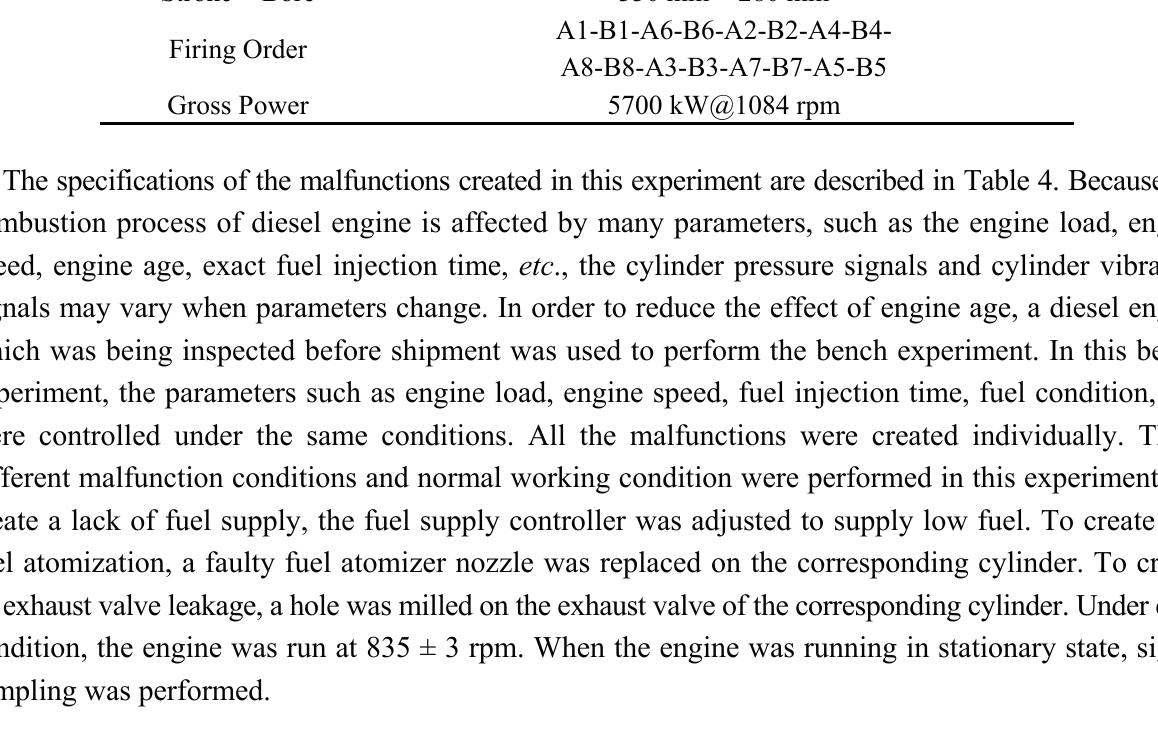
Table 4. Malfunction experiment